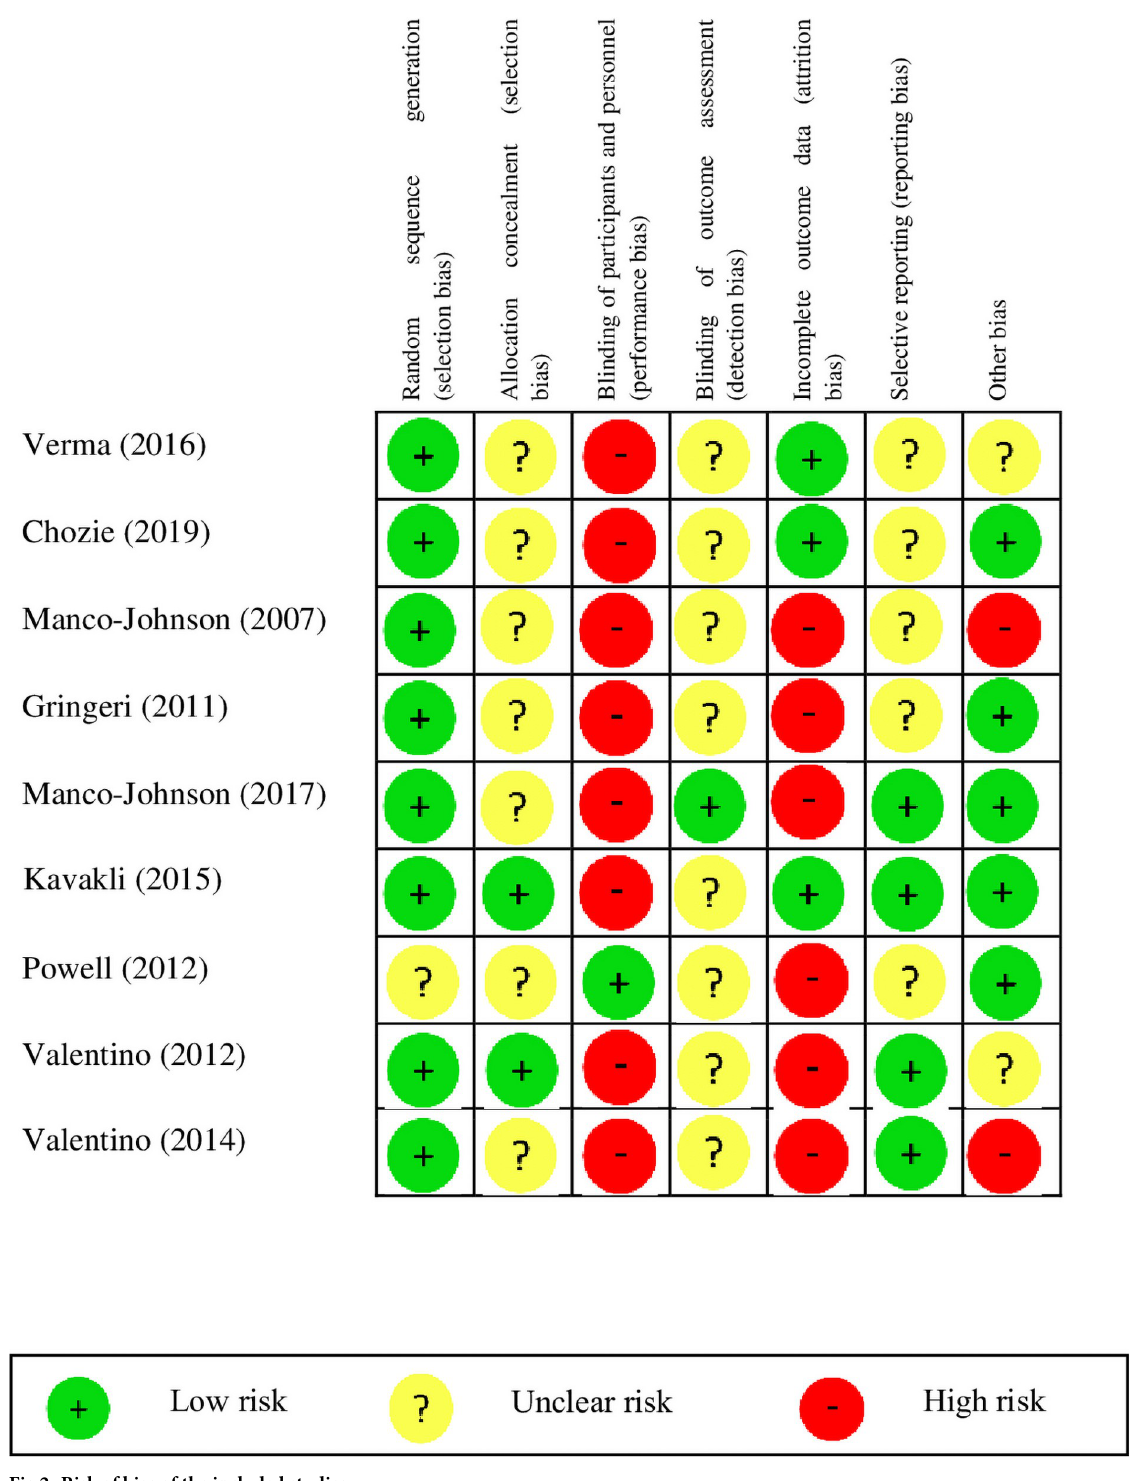
PLOS ONE | https://doi.org/10.1371/journal.pone.0262273 January 14,